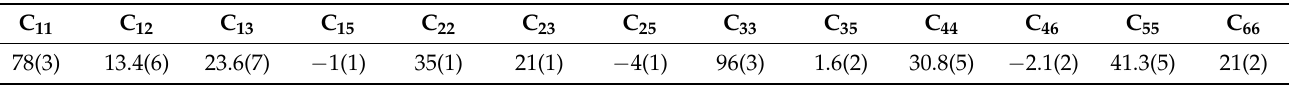
Table 3. Elastic tensor components C ij for LiAl(IO 3 ) 4 , in GPa, as obtained after a full geometry optimization. The errors obtained via DFT are provided in brackets.